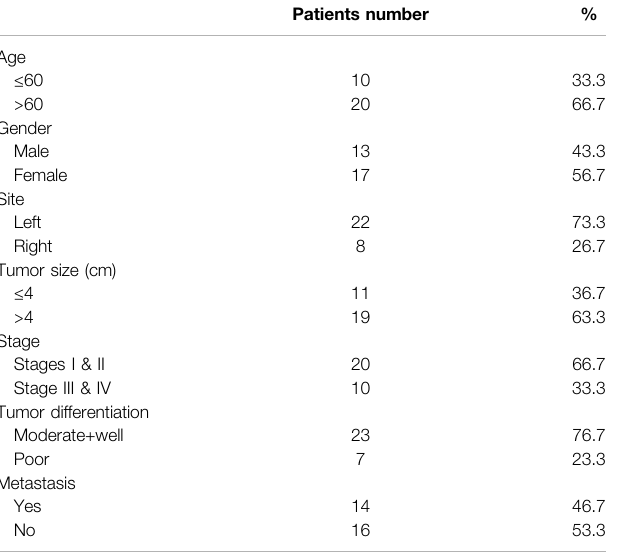
TABLE 5 | The baseline characters of Fn-infected CRC patients.